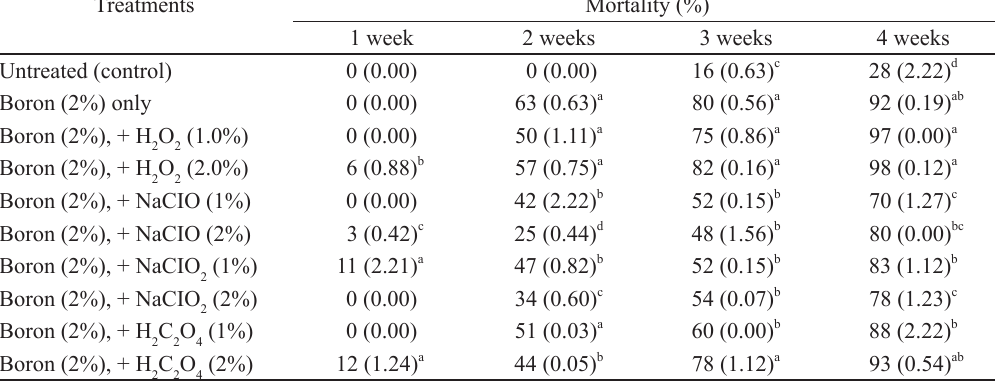
Average termite mortality on treated rubberwood with different